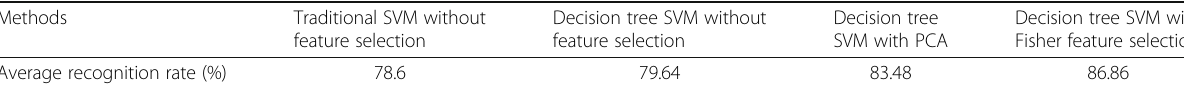
Table 9 Average recognition rate of feature selection methods on EMO-DB (%) Methods